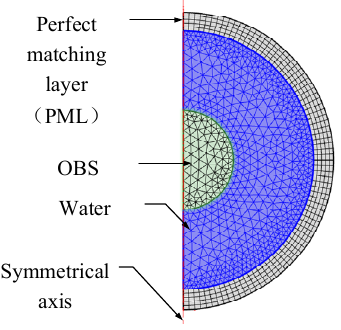
Figure 8. Axial symmetry model of the OBS in free field. Table 2. Material parameters in the free field.